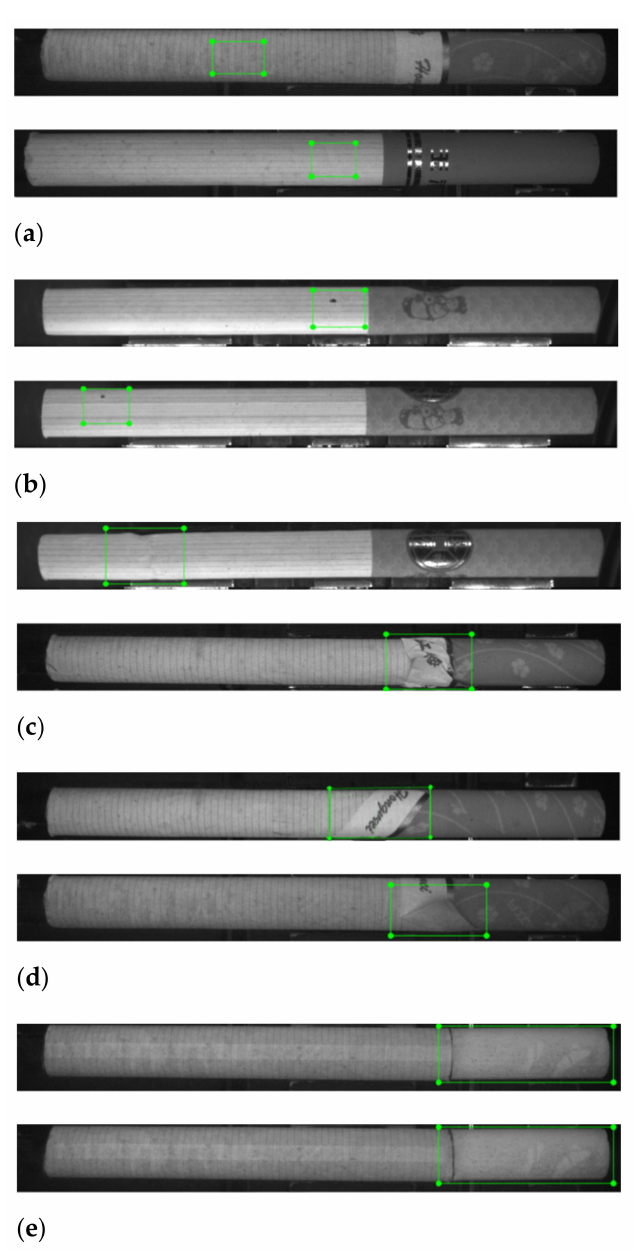
Figure 10. Example of cigarette labeling: ( a ) normal cigarette label; ( b ) dotted cigarette label; ( c ) folded cigarette label; ( d ) malposed cigarette label; ( e ) unfiltered cigarette